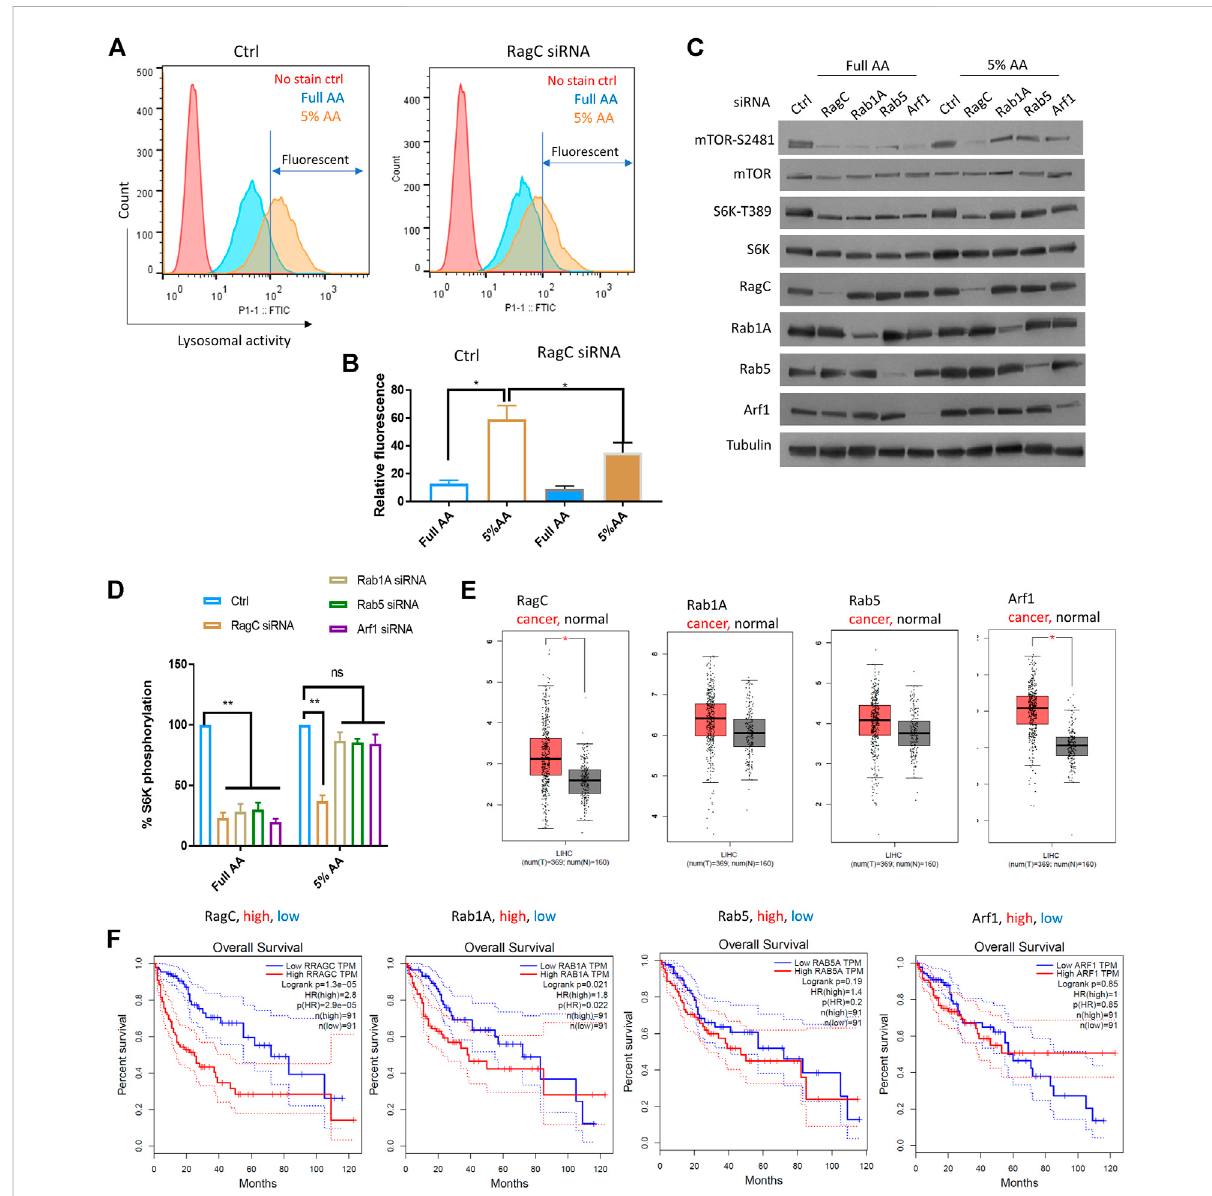
FIGURE 4 RagC activated mTOR in response to elevated lysosomal activity and predicted poor survival in LIHC patients. (A) AA starvation increased lysosomalactivityinaRagC-dependentmanner.HepG2cellswereknockeddownofRagCexpressionbysiRNAthenstarvedinculturemedium with 5% of normal AA for 18 h, stained with lysosomal activity probe and analyzed by fl ow cytometry. (B) Quanti fi cation of N = 2 experiments in (A) . Student ’ s t test p < 0.05(*). (C) mTOR activity was sensitive to RagC knockdown but not Rab1A, Rab5, or Arf1 knockdown in HepG2 cells with elevated lysosomal activity (induced by 5% AA starvation). Indicated proteins were examined by Western blotting. Representative data were shown. (D) Quanti fi cation of Western blot data in (C) . Blots were quanti fi ed by ImageJ and normalized to control (100%). N = 3 experiments were tested by Student ’ s t test p < 0.01(**), not signi fi cant (ns). (E) Expression of indicated genes in N = 369 LIHC cancer patients and N = 160 matched normal controls. p < 0.01(*). LIHC patient data from TGCA were analyzed with GEPIA bioinformatics tools. (F) Expression of RagC but not other GTPases is a robust prognostic predictor for LIHC patients. Overall Survival (OS) data of LIHC patients with top 25% high (N = 91) and 25% low (N = 91) expression of indicated genes were plotted in Kaplan Meier curves and tested by Log-rank test. p < 0.01 was considered signi fi cant. HR, hazard ratio. TPM, transcript per